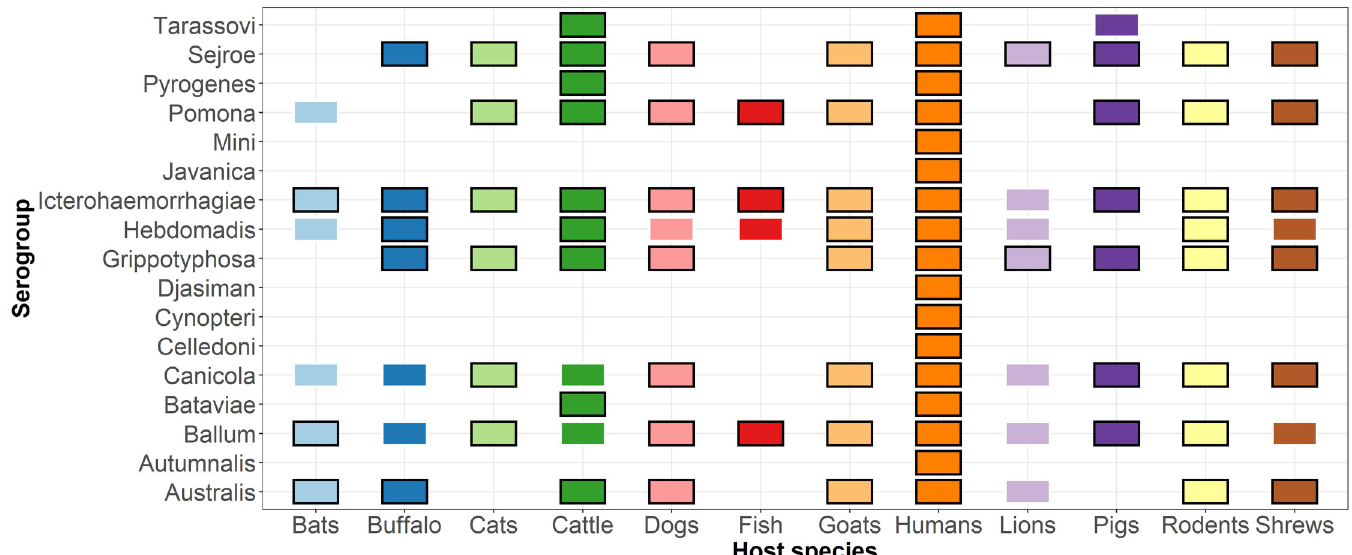
Fig 3. Serogroups used in the Microscopic Agglutination Test (MAT) for detection of antibodies to Leptospira in humans and animals in Tanzania (1997–2019). The coloured box indicates that samples were screened for these serogroups and the black outline indicates that the serogroup was detected (n = 28).